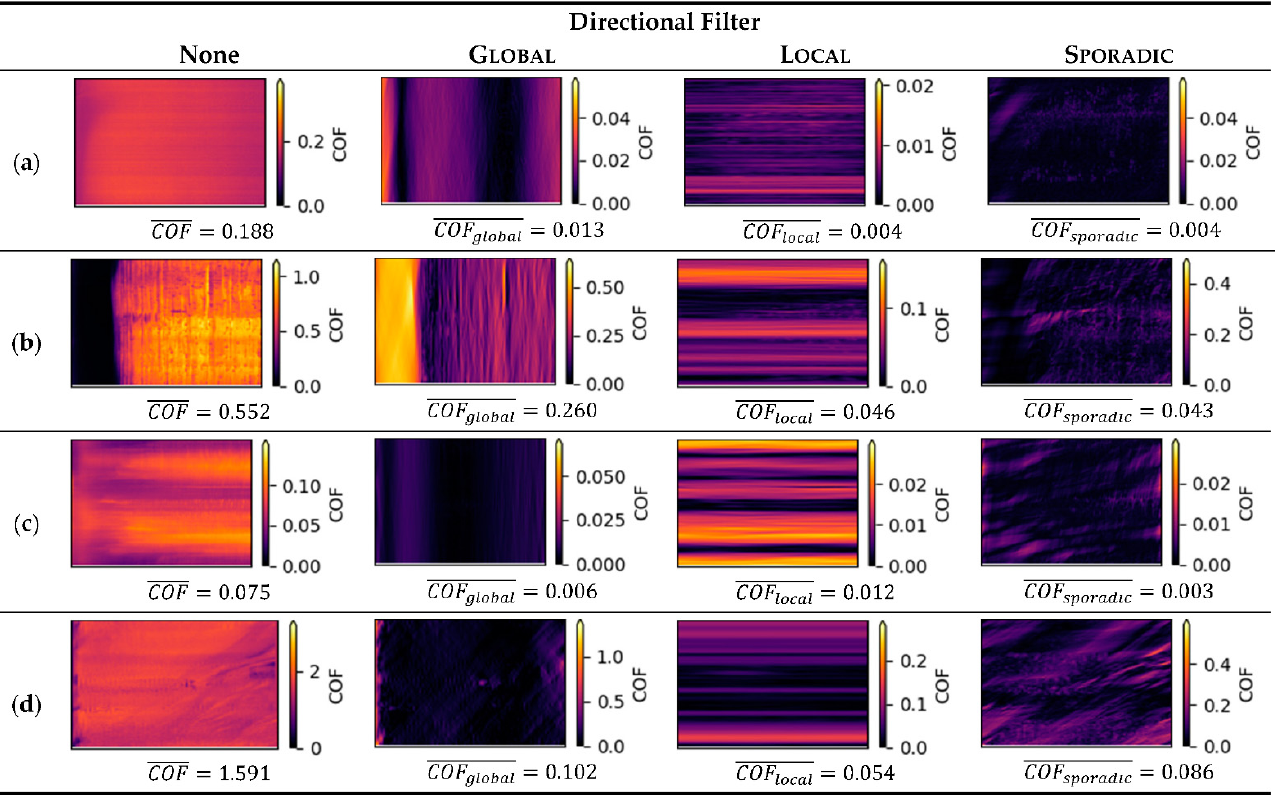
Figure 9. Triboscopy images for the proposed directional filtering technique G LOBAL , L OCAL , and S PORADIC . Below every filtered image, the directional mean coefficient of friction is given, with column “None” being the original images, including the mean coefficient of friction, which also corresponds to the U NIFORM case. Scales for friction coefficient are individually scaled for each image to emphasize the quality of friction features of each contribution, reducing the visibility of their quantitative contribution. Tribological testing cases given as examples in rows are ( a ) a-C:Cu, steel ball, humid air, with no dominant directional features; ( b ) ta-C 3 coating, steel ball, ambient air with strong G LOBAL and S PORADIC features; ( c ) ta-C 3 coating, ta-C 1 ball, ambient air, with mostly LOCAL features; ( d ) ta-C 3 coating, ta-C 1 ball, nitrogen, with SPORADIC features.